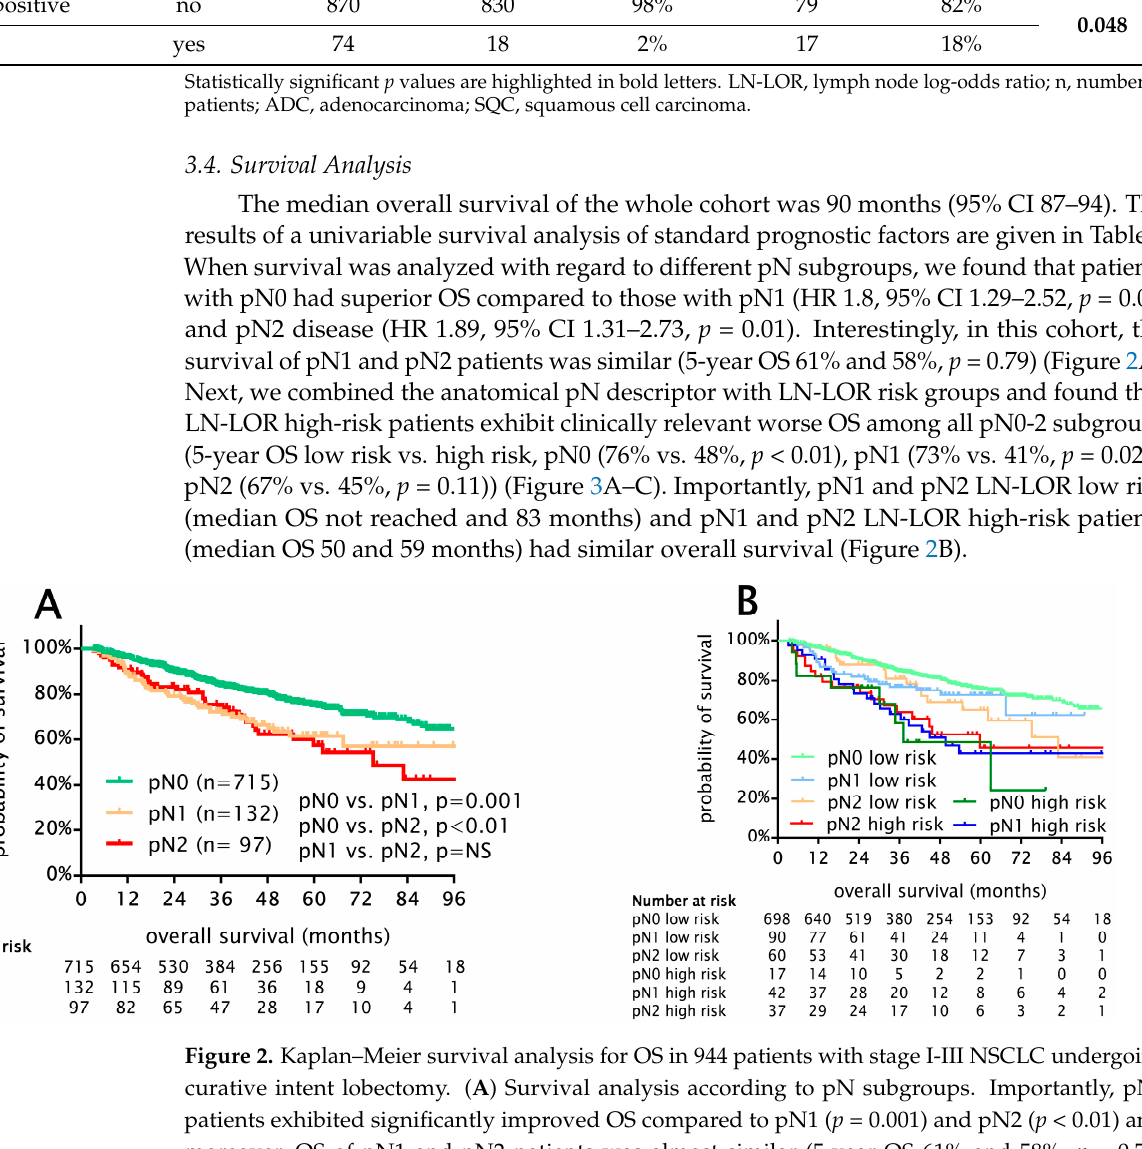
Figure 3. Kaplan–Meier survival analysis for OS in 944 patients with stage I-III NSCLC undergoing curative intent lobectomy. Survival analysis strati fi ed by pN categories and LN-LOR risk groups. ( A ) OS in pN0 patients only. LN-LOR high risk was associated with signi fi cantly worse OS (5-year OS 76% vs. 48%, p < 0.01) among pN0 patients. Importantly, 17 patients in the LN-LOR high-risk group did not undergo adequate lymphadenectomy. ( B ) OS in pN1 patients only. LN-LOR high risk was associated with signi fi cantly worse OS (5-year OS 73% vs. 41%, p = 0.024) among pN1 patients. ( C ) OS in pN2 patients only. We found a non-signi fi cant tendency for worse OS in LN-LOR high- risk patients in the pN2 subgroup (5-year OS 67% vs. 45%, p = 0.11). Importantly, pN1 and pN2 LN- LOR low risk (median OS 87 and 83 months) and pN1 and pN2 LN-LOR high-risk patients (median OS 50 and 59 months) had similar survival. LN-LOR, lymph node log-odds ratio; NS, not signi fi cant; HR, hazard ratio. In univariable survival analysis we found that, besides LN-LOR, clinicopathological parameters such as sex, age, histological subtype, pT stage, pN stage, overall stage and the use of adjuvant treatment were signi fi cant factors for OS (Table 3). We further performed a multivariable Cox regression analysis adjusted for parameters such as sex, age, histological subtype, pT stage, pN stage, overall stage, use of neoadjuvant treatment and use of adjuvant treatment. Importantly, multivariable analysis revealed that LN-LOR remained as an independently signi fi cant factor for OS (low-risk group, HR 0.48, 95%CI 0.32–0.72, p = 0.001) (Table 3).